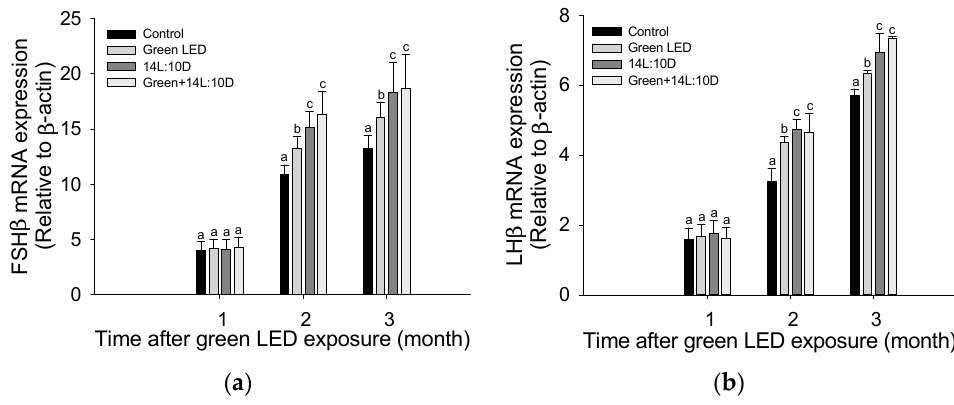
Figure 2. Chub mackerel, Scomber japonicus , were exposed to a 12 h light and 12 h dark photoperiod, either under fluorescent lighting (Control) or under green LEDs (Green LED); mackerel were also exposed to an extended 14 h light and 10 h dark photoperiod under fluorescent lighting (14L:10D) or green LEDs (Green+14L:10D). Total RNA were extracted from the brains of fish (n = 40; full length, 33.7 ± 3.5 cm; weight, 453.5 ± 10.4 g per group) and subjected to quantitative polymerase chain reaction to assess the expression of ( a ) FSH β mRNA and ( b ) LH β mRNA at onset of the experiment, after 1 month, and after 2 months. Vertical bars denote standard errors. Values with different superscripts (a, b, or c) within a given observation period indicate significant differences between groups ( p < 0.05) as determined using Tukey’s multiple range test.